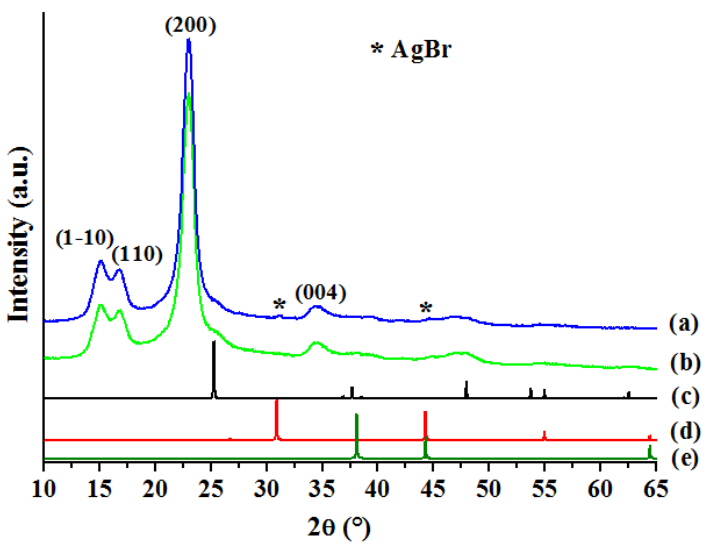
Figure 4. X-ray di ff ractograms of fresh paper–TiO 2 –AgBr ( a ), paper–TiO 2 –AgBr after photocatalytic test ( b ), TiO 2 anatase ICSD reference ( n ◦ 9853) ( c ), AgBr ICSD reference ( n ◦ 52246) ( d ), metallic Ag ICSD reference ( n ◦ 44387) ( e ).